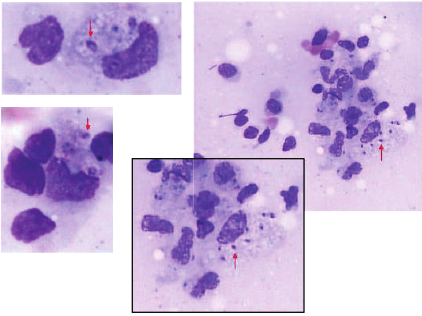
Figure 4: Numerous intracytoplasmic corpuscles of Leishmania spp. (red arrows) identified on histopathologic